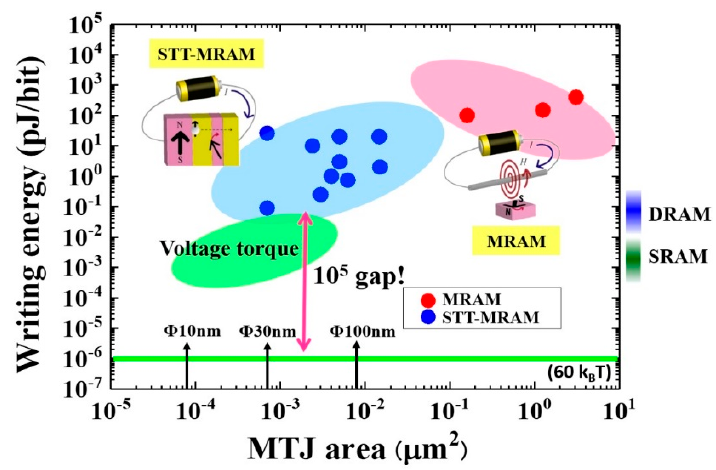
Figure 1. Reported writing energy for toggle magnetoresistive random-access memory (MRAM) (red dots) and spin-transfer torque-based switching (STT-MRAM) (blue dots) as a function of magnetic tunnel junctions (MTJ) cell size and the target area for voltage-torque MRAM.